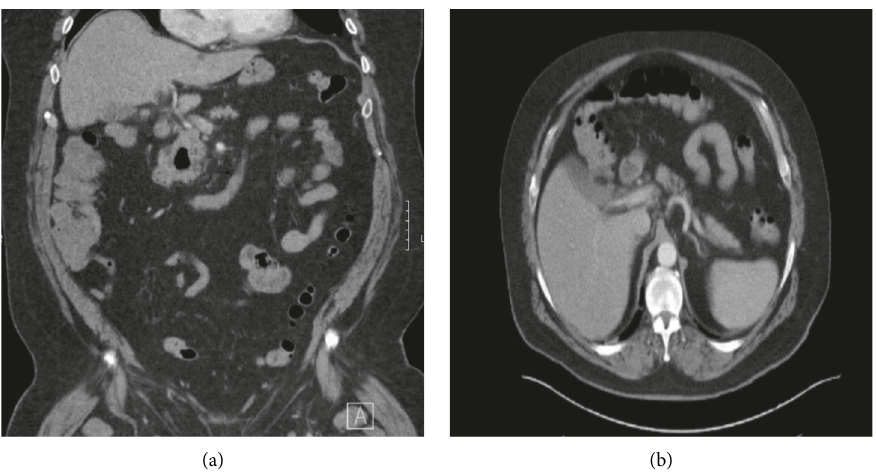
Figure 1: (a), (b) CT scan at initial presentation: moderate stool burden, no other